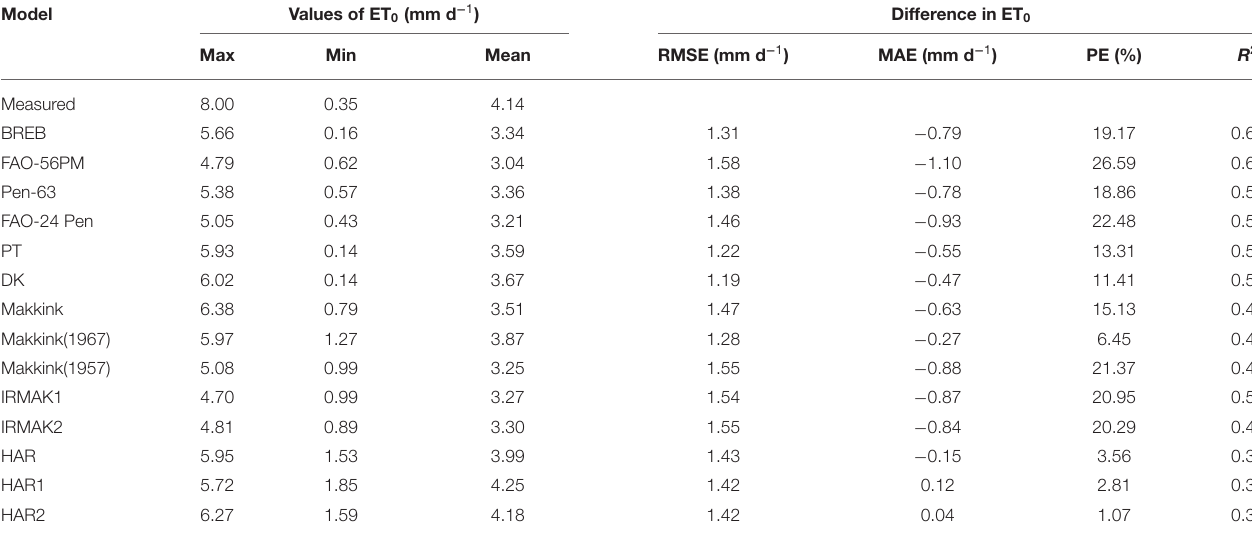
TABLE 4 | Summary of statistics for daily ET 0 between lysimeter measurements and model estimates during the growing season (data points = 189).